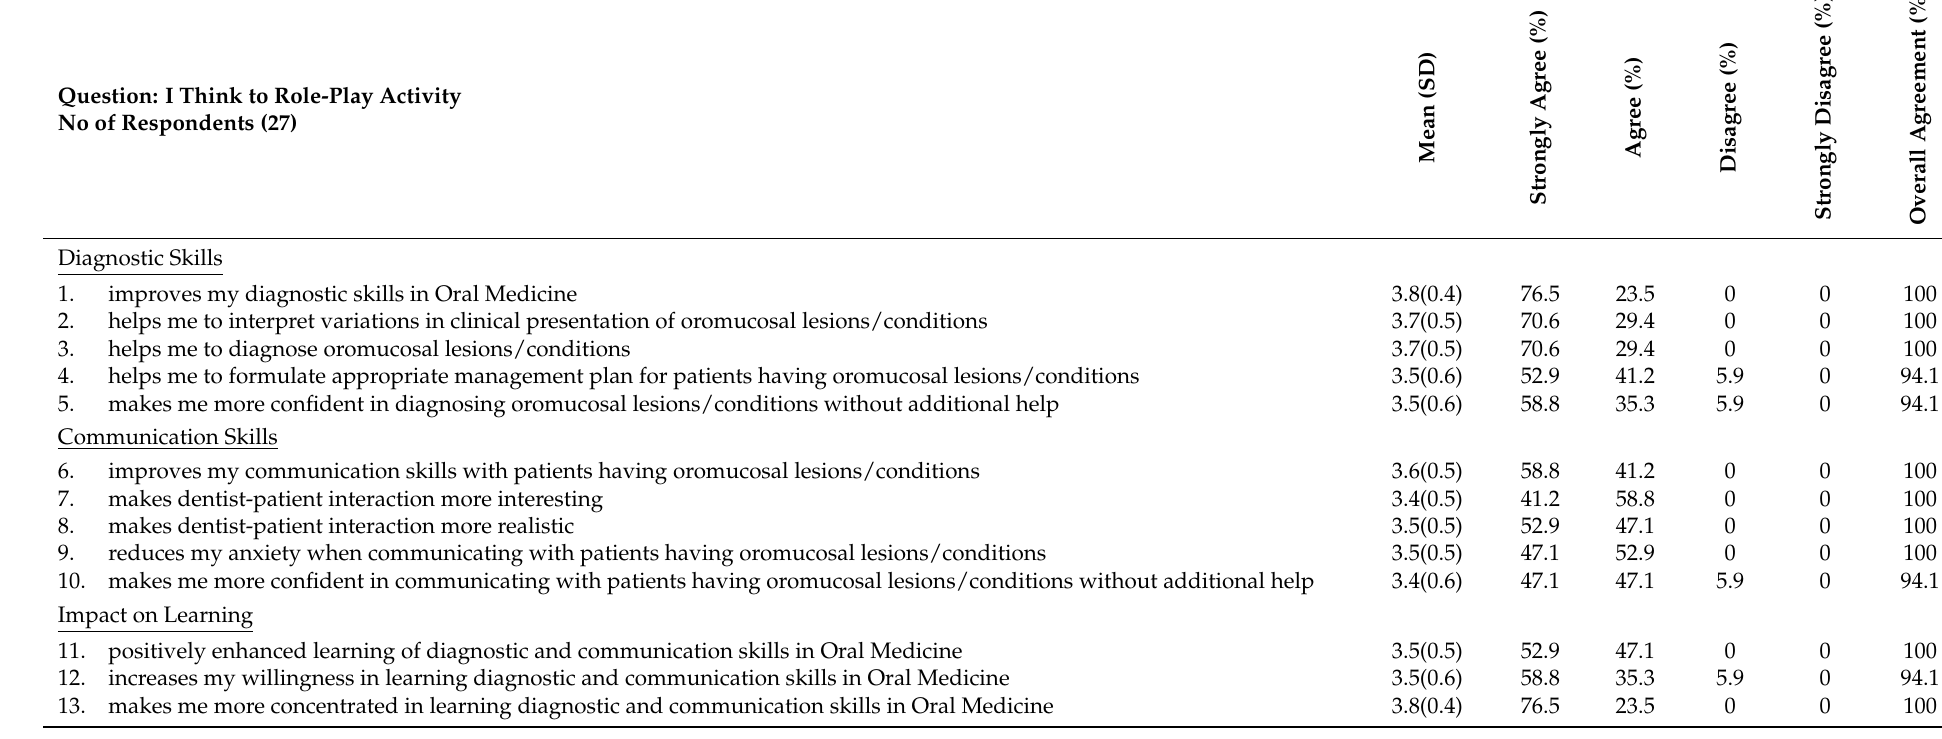
Table 3. Distribution of students’ perceived usefulness of role play activity ( n =